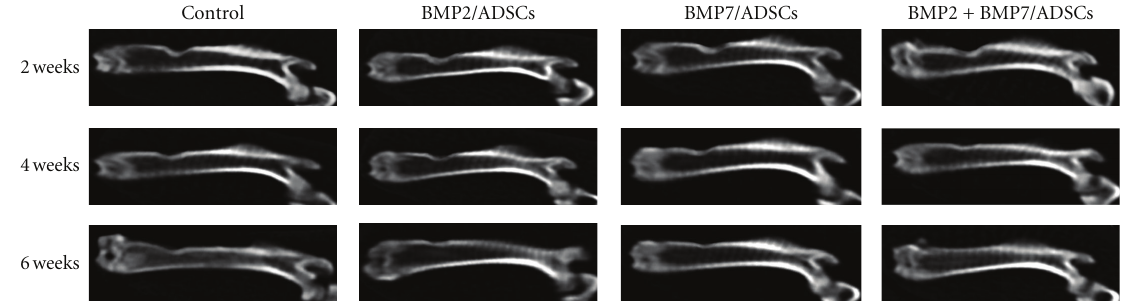
Figure 5: X-rays photograph of rat femurs defects in control, BMP2/ADSCs, BMP7/ADSCs, and BMP2 + BMP7/ADSCs groups at 2 weeks, 4 weeks, and 6 weeks after surgery.